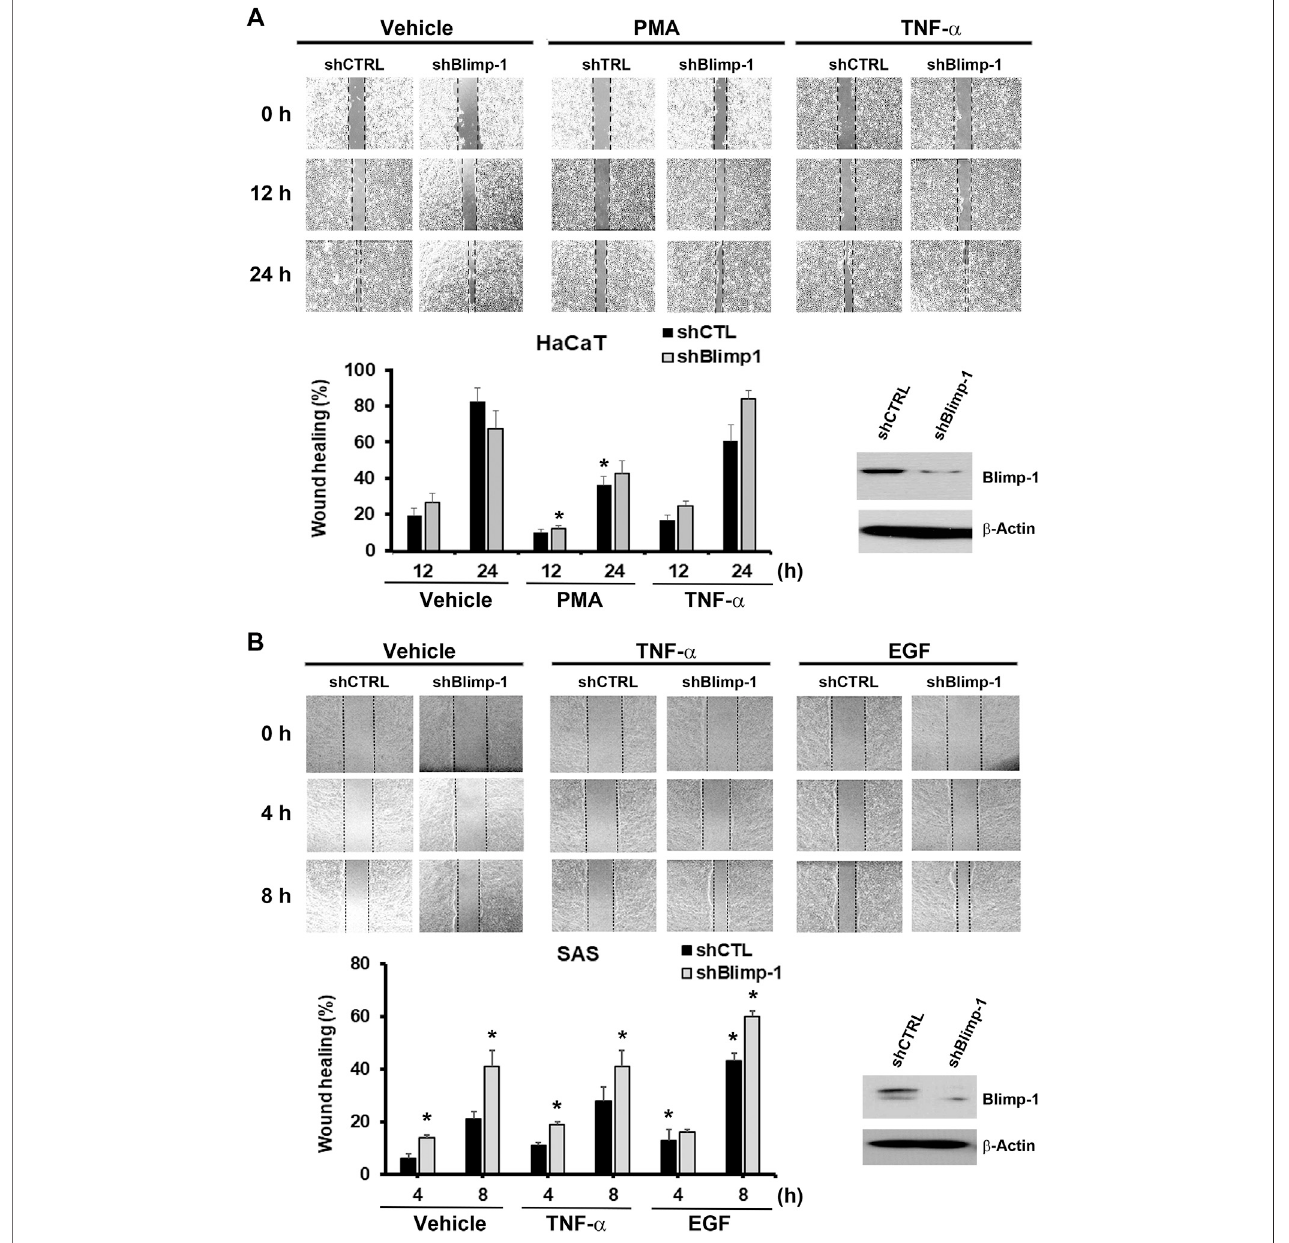
FIGURE 5| Blimp-1 negatively regulates cell migration in SCC but not HaCaT cells. After transfection of silencing Blimp-1 and control shRNA, HaCaT (A) , SAS (B) and Cal-27 (C) cellswereseededinwound-healing assaykitand grownovernightforattachment. ThenthekitswereremovedandfreshDMEMmediumwithmitomycin C (5 μ g/ml) was treated. After 30 min, cells were stimulated with PMA (30 nM), TNF- α (10 ng/ml) or EGF (50 ng/ml). Photography (100x) was taken by microscopy. Dashed lines represent boundaries of the wounds. The percentage of wound closure from the denuded gap after incubation for different times was determined. * p < 0.05(mean ±S.E.M., n =3), indicating the signi fi cantenhancement effectsofshBlimp-1 and EGF, and theinhibitoryeffectofPMA oncell migration ascomparedto control